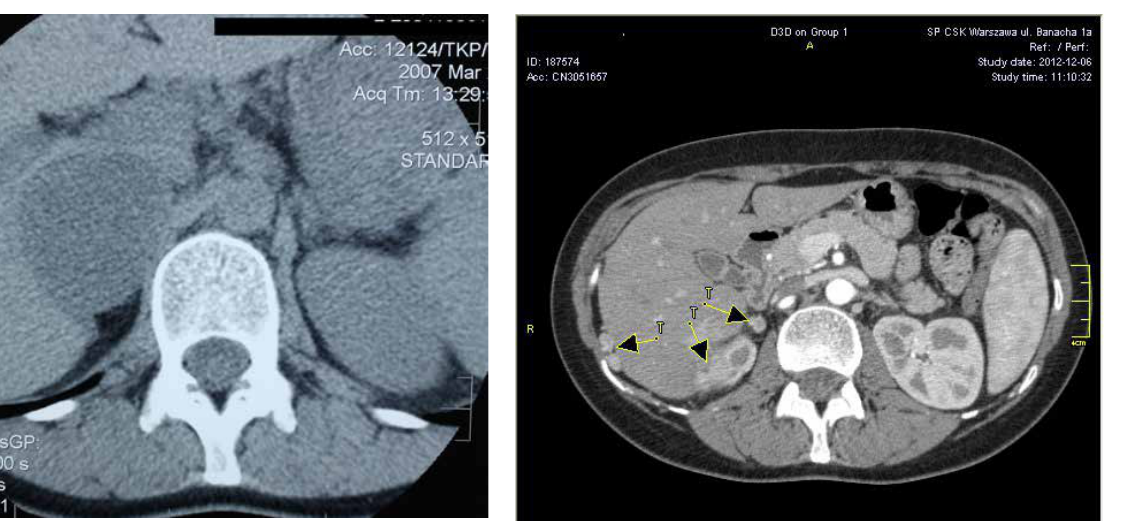
Figure 1 : Preoperative CT scan from 2007. Tumor of the right adrenal gland, 67x48 mm in dimension and of 30 Hounsfield units density.